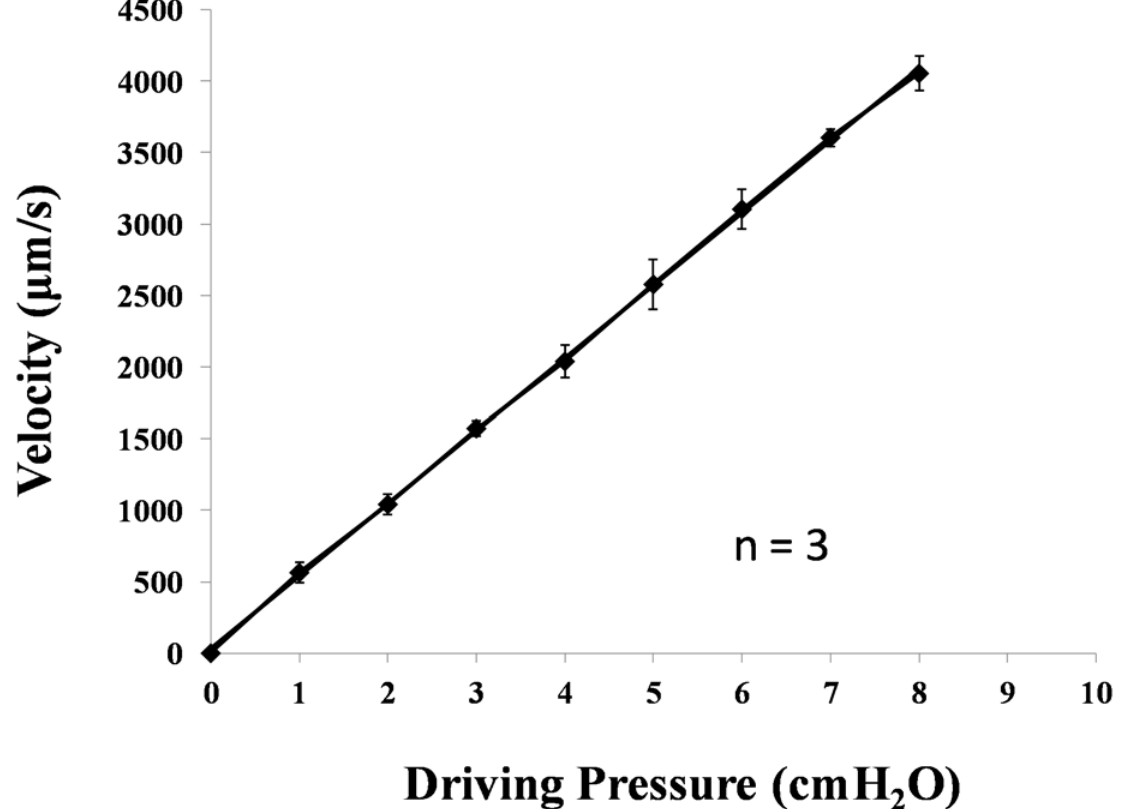
Figure 1. Mean perfusion flow velocity as a function of the driving pressure. The perfusion flow velocity was determined by tracking the movement of a fluorescent bead of 3 μ m diameter when the vessel was cannulated and perfused at a known driving pressure measured from a water manometer. The movement of a fluorescent bead was recorded using our imaging system at various pressures for each vessel. Three vessels were tested and values shown are mean ±